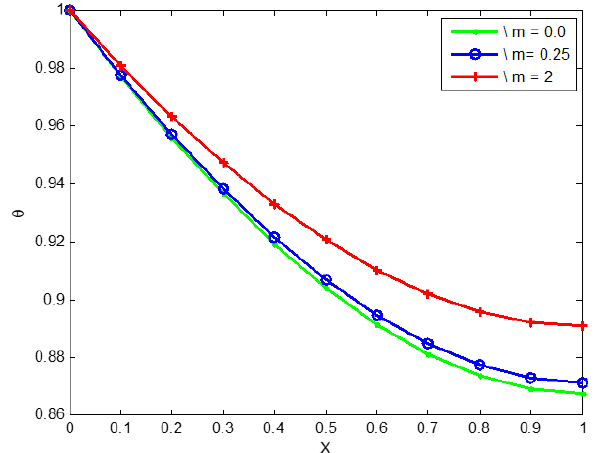
Figure 9. Effect of different values of power index of heat coefficient on temperature distribution of Concave Aluminium porous